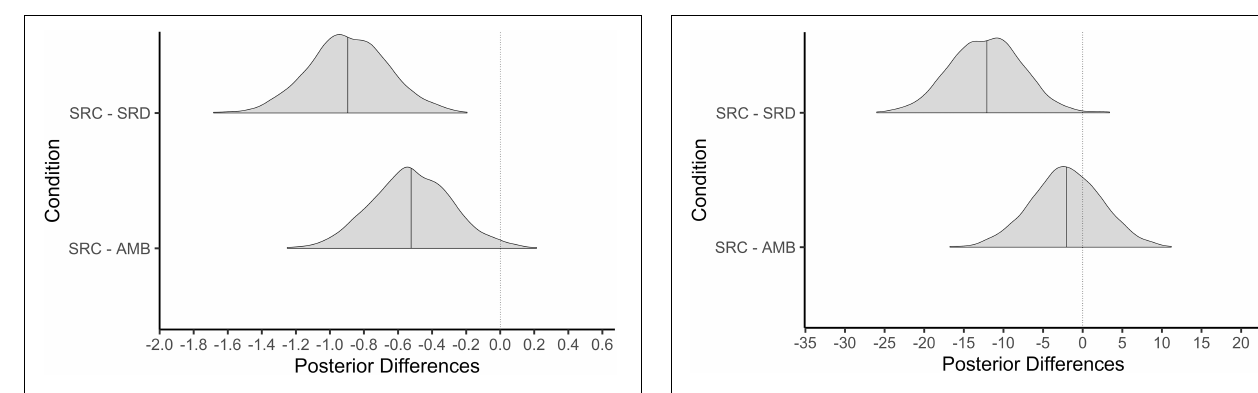
FIGURE 3 | Posterior differences in psychological stress by condition. SRC, shared reality confirmed; SRD, shared reality disconfirmed; AMB, ambiguous. Solid line represents the 50th percentile and the dotted line on 0 = no difference.